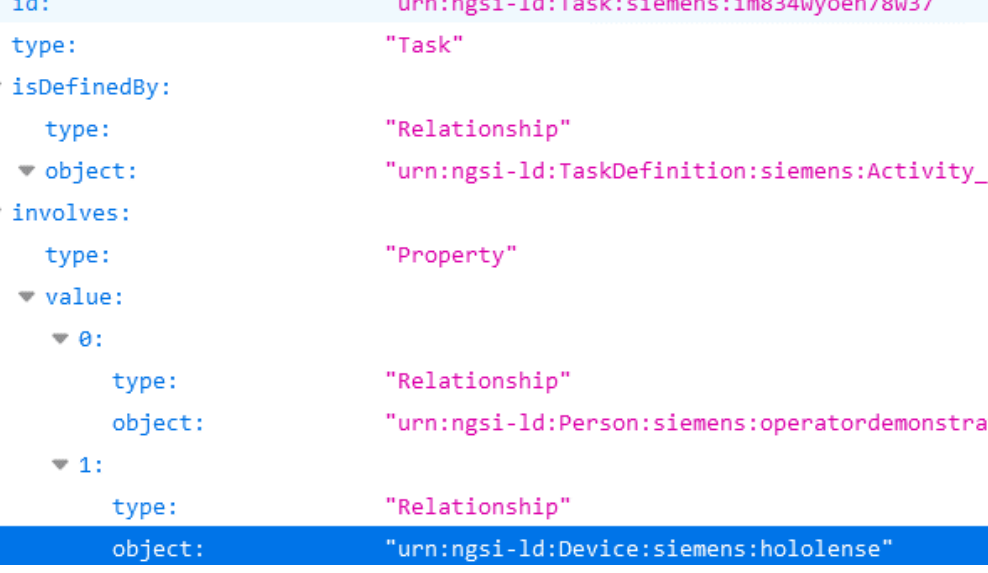
Figure 3. Example of a json message published in the context broker.